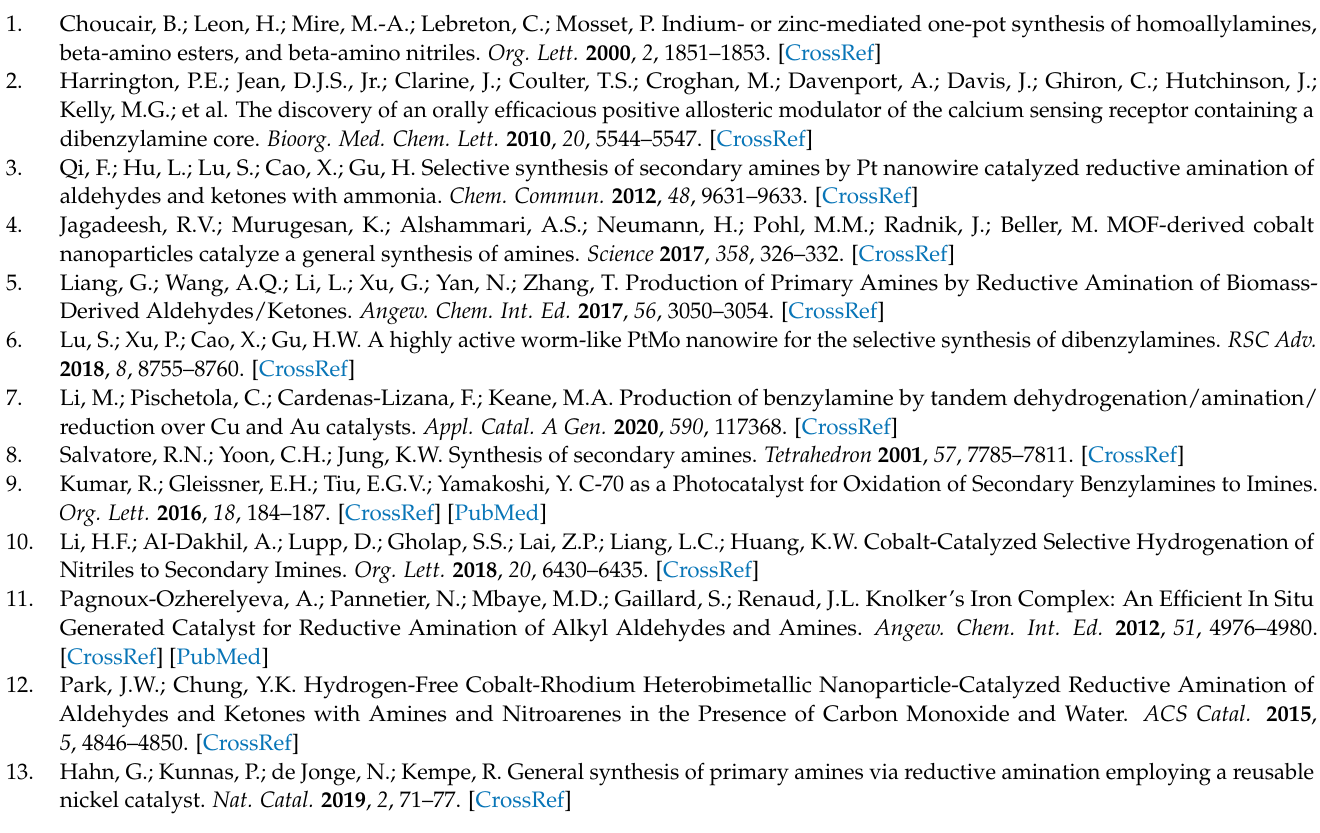
N-[(4-fluorophenyl)methyl]methanamine. Figure S18: GC-MS spectras of 1-(4-fluorophenyl)-N-[(4- fluorophenyl)methyl]methanamine. Figure S19: 1 H NMR spectras of N, N-bis(4-chlorobenzyl)amine. Figure S20: GC-MS spectras of N, N-bis(4-chlorobenzyl)amine. Figure S21: 1 H NMR spectras of bis- (5-methyl-furan-2-ylmethyl)-amine. Figure S22: GC-MS spectras of bis-(5-methyl-furan-2-ylmethyl)- amine. Figure S23: 1 H NMR spectras of bis(2-methylbenzyl)amine. Figure S24: GC-MS spectras of bis(2-methylbenzyl)amine. Figure S25: 1 H NMR spectras of N, N-bis(m-methoxybenzyl)amine. Figure S26: GC-MS spectras of N, N-bis(m-methoxybenzyl)amine. Figure S27: 1 H NMR spectras of bis(3-fluorobenzyl)amine. Figure S28: GC-MS spectras of bis(3-fluorobenzyl)amine. Figure S29: 1 H NMR spectra of N, N-bis(3-chlorobenzyl)amine. Figure S30: GC-MS spectras of N, N-bis(3- chlorobenzyl)amine. Figure S31: 1 H NMR spectra of bis(4-aminobenzyl)amine. Figure S32: 1 H NMR spectra of N, N-bis(3-hydroxybenzyl)amine. Figure S33: GC-MS spectras of N, N-bis(3-